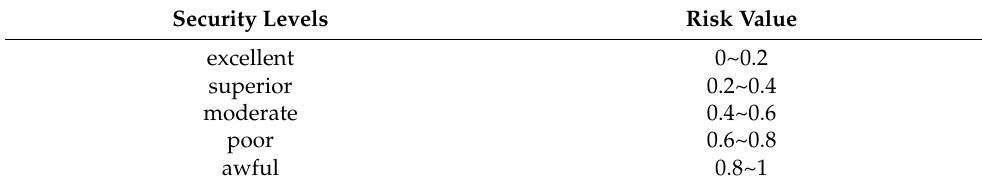
Table 5. Security risk level based on entropy-weight fuzzy set